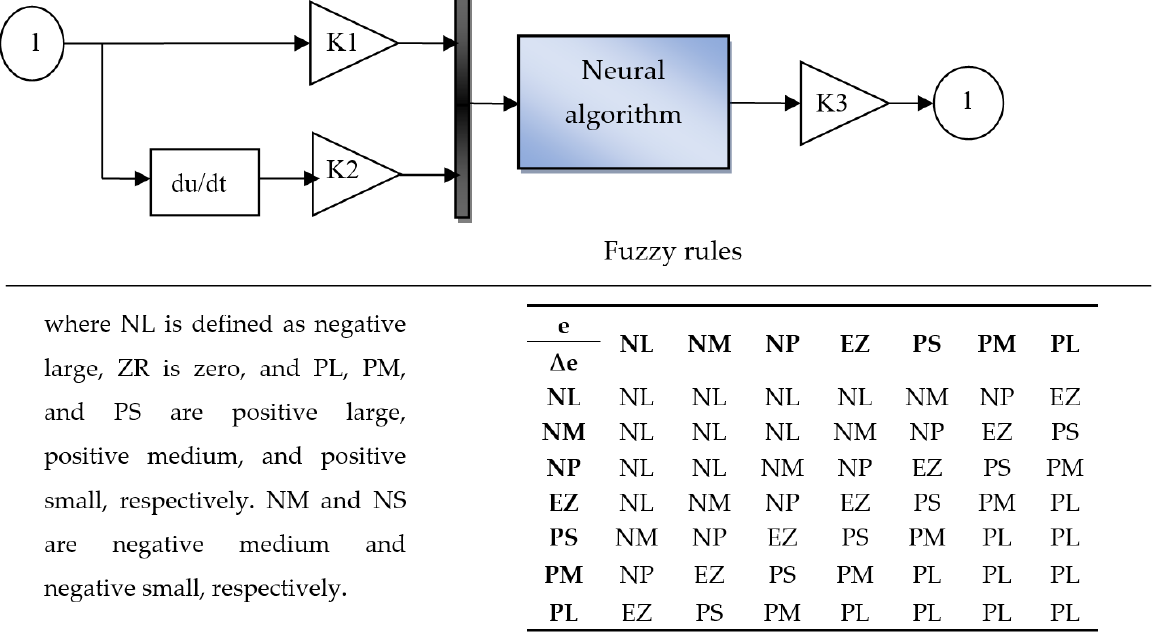
Figure 5. Membership functions. Regarding the neural networks, eight cells were selected in the inner layer, and in the outer and front layer, one cell and two cells were selected, respectively. The characteristics of the neural network used to perform ANFIS algorithms are shown in Table 1. In order to implement the neural networks, a conjugate gradient with Beale–Powell restarts was used. The following functions were also used to obtain the neural networks: tansig, purelin, and traincgb.